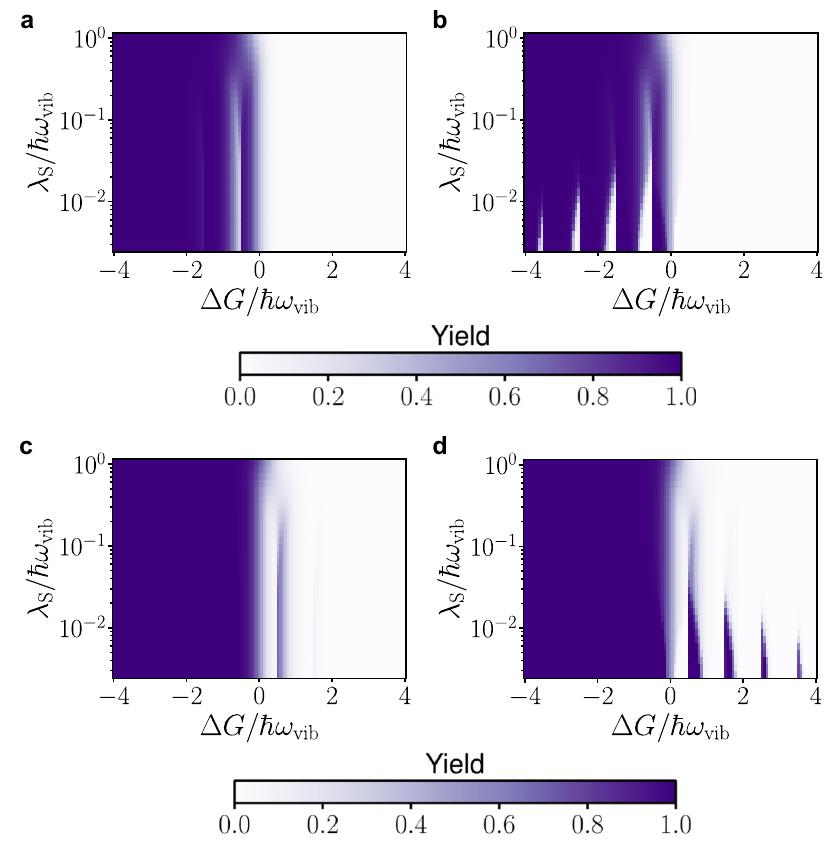
Fig. 5 Reaction yield for asymmetric light-matter coupling. a , c The yield of the reaction when only the product (reactant) weakly couples with light. b , d Analogous plots under strong coupling 2 g P ( T = 298K when ℏ ω vib = 185 meV), S = 3.5, P − = 0.08 N Γ ↓ and N = 10 7 . We assume the same scattering parameters W ij and decay rates Γ ↓ , κ as in Fig.